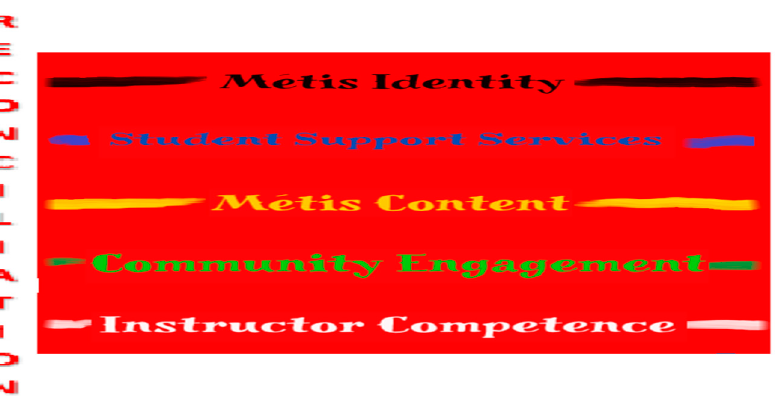
Figure 1. M é tissage-as-reconciliation. Note. The M é tissage-as-reconciliation framework is inclusive Figure 1. Métissage-as-reconciliation. Note. The Métissage-as-reconciliation framework is inclu- of the following elements: M é tis identity, student support services, M é tis content, community sive of the following elements: Métis identity, student support services, Métis content, community engagement, and instructor competence embedded within engagement, and instructor competence embedded within reconciliation.